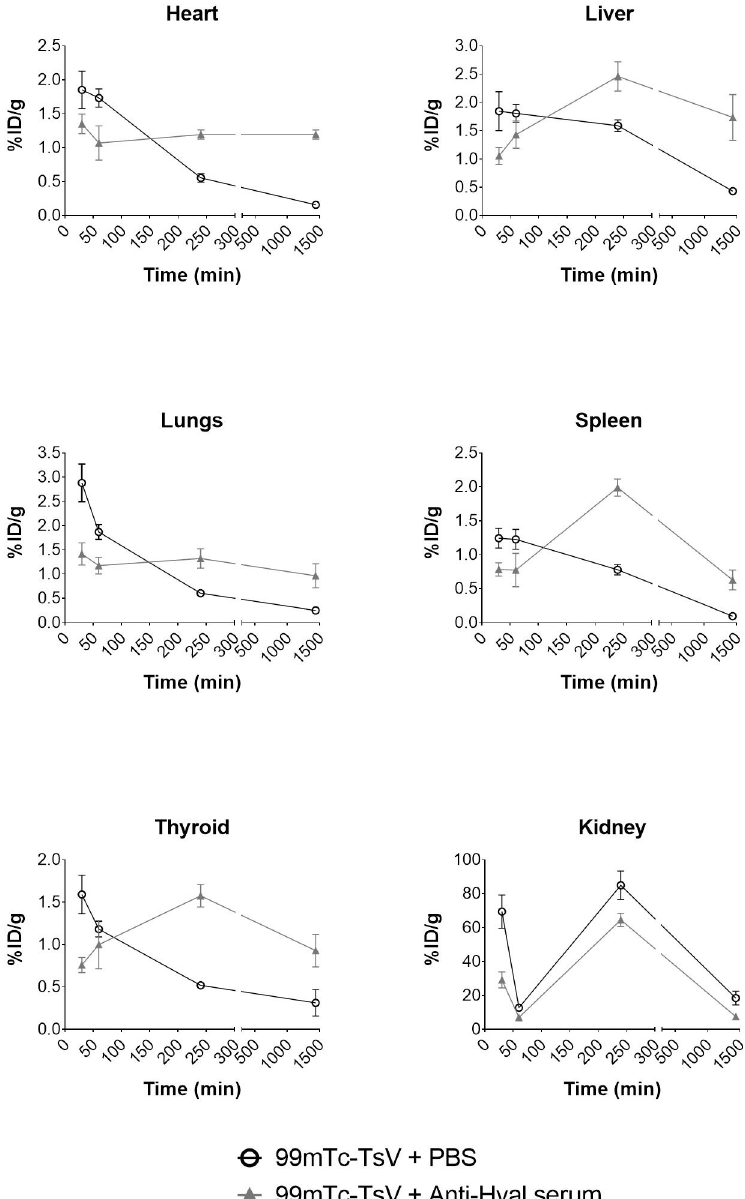
Fig 5. Biodistribution of 99m Tc-TsV. 99m Tc-TsV (3.7 MBq) diluted in PBS ( 99m Tc-TsV + PBS) or neutralized with anti-hyaluronidase serum ( 99m Tc-TsV + Anti-Hyal serum) was intramuscularly injected in Swiss mice (6–8 weeks old, 24–28 g; n = 6 per group). Radioactivity levels were measured in the heart, liver, lungs, spleen, thyroid and kidneys at 30, 60, 240 and 1440 min post-injection. The results are expressed as the percentage of injected dose/g of tissue (%ID/ g). All values are presented as the mean ± S.E.M. of two independent experiments. Statistical analysis was performed using two-way ANOVA (factors: serum administration and time). Anti-hyaluronidase serum significantly affected the mean distribution of TsV to the liver (p < 0.0001), spleen (p = 0.0115), and kidneys (p = 0.0009), while time was a significant factor for TsV distribution to the heart (p < 0.0001), liver (p < 0.0001), lungs (p = 0.0095), spleen (p = 0.0008), and kidneys (p < 0.0001). A significant interaction between serum administration and time was observed in the heart (p = 0.00003), liver (p < 0.0001), spleen (p = 0.0337), and thyroid (p <